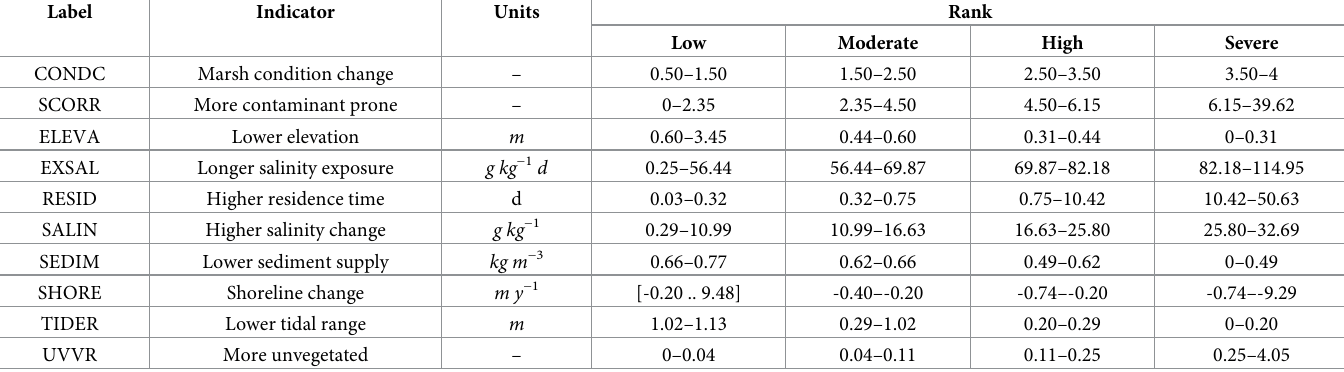
Table 1. Vulnerability indicators. Thresholds for each indicator were determined by percentile classification for each data layer. The original values in each dataset were reorganized for higher rank to indicate higher vulnerability.